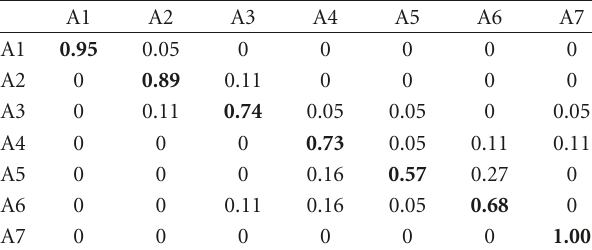
Table 5: Confusion matrix at resolution level